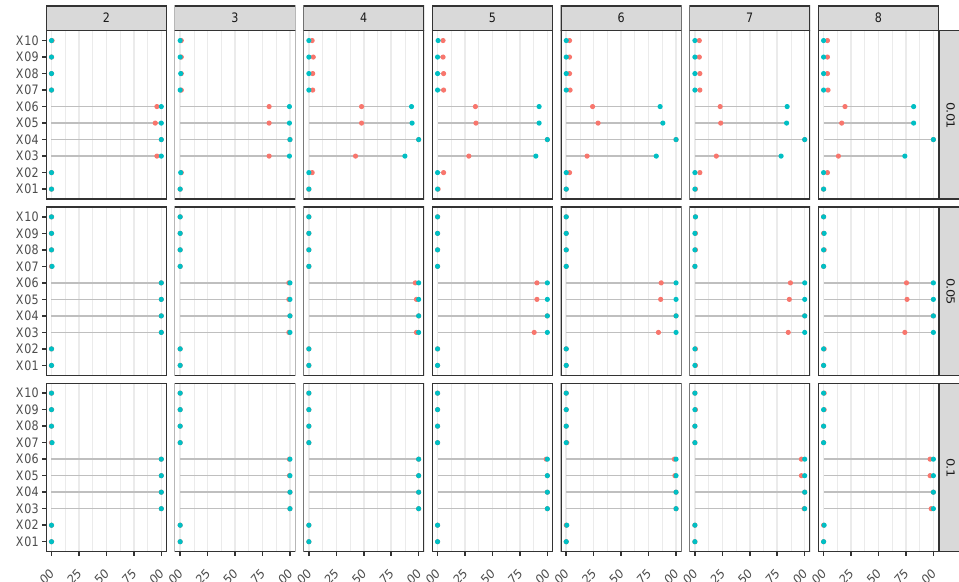
Figure 7. Model M1 (Tibishirani). Proportion of rejections of null hypothesis based on k -FWE test with k = 1 for 10 input variables, different combinations of hidden layer sizes ( m ∈ { 2,3, . . . ,8 } ), and weight-decay values ( λ ∈ { 0.01,0.05,0.1 } ). Nominal FWE was fixed at α = 0.10, 500 Monte Carlo runs, B = 999 bootstrap replicates, and n = 300 (in red) and n = 1000 (in blue).